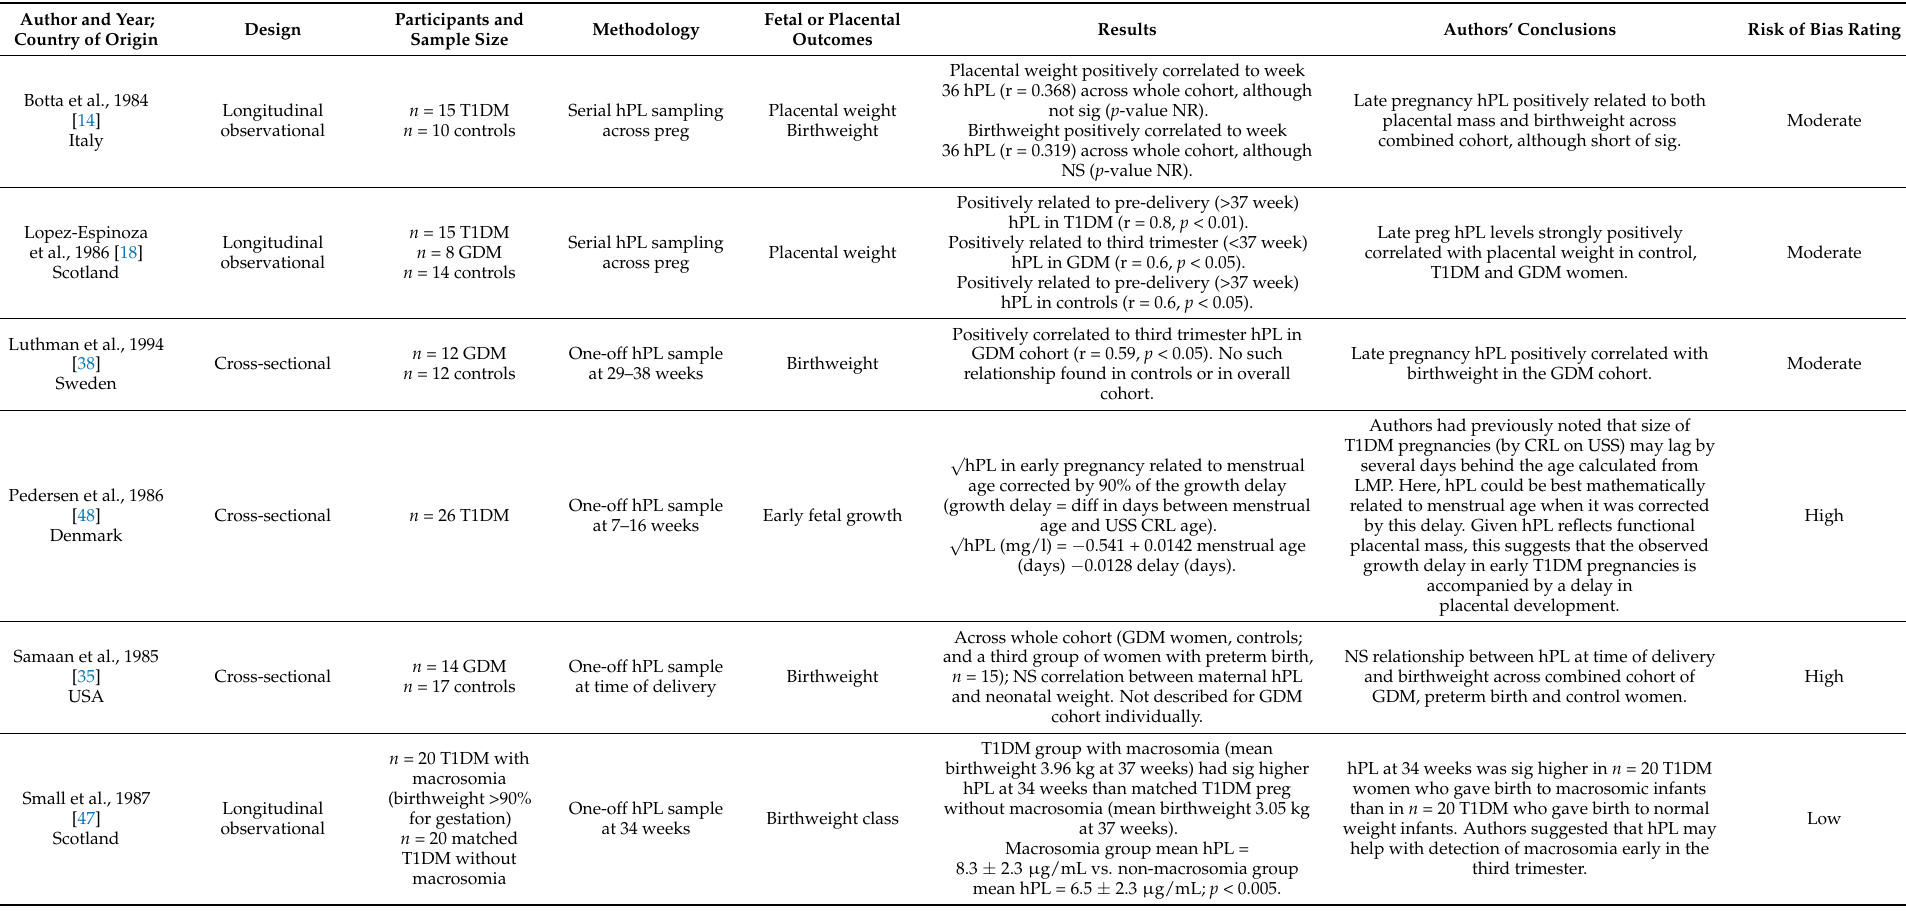
Table A5. Studies examining hPL in relation to fetal, neonatal or placental outcomes in pregnancies affected by maternal pre-gestational/gestational diabetes—7